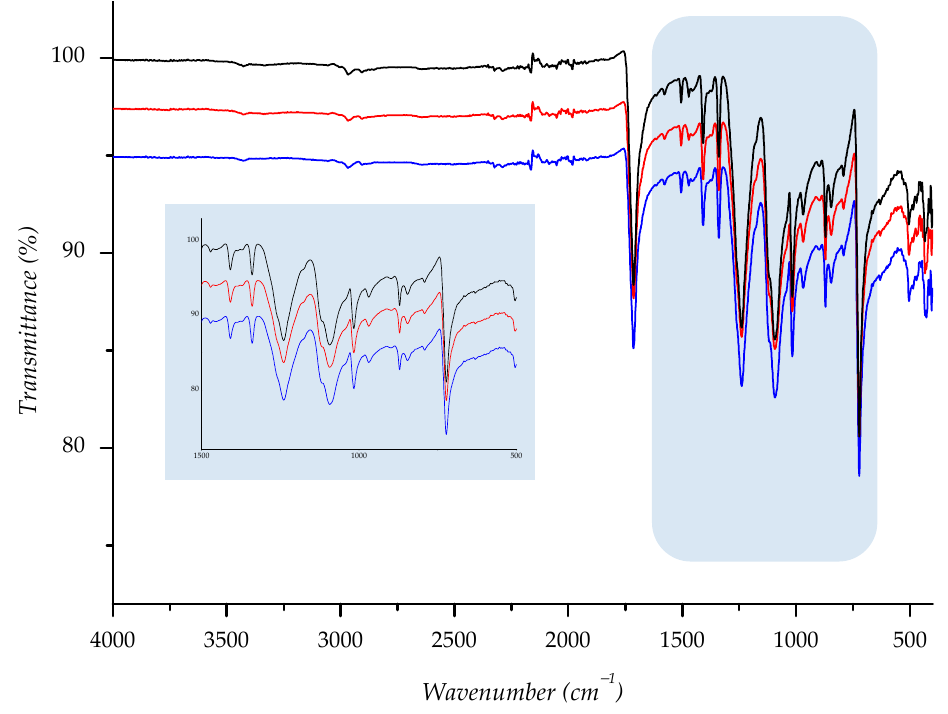
Figure 16. IR spectra of investigated sample F3 ((—) = starting material; (—) = material aged in sun; (—) = material aged in shade) with enlarged fingerprint region (colored in blue).